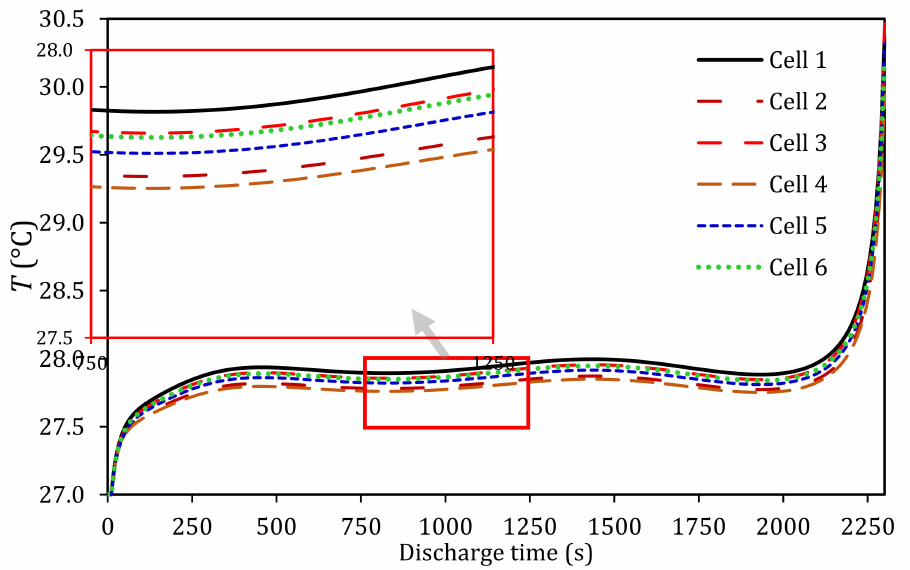
Figure 11. LIB cells temperature characteristic at a 3C discharge rate with 3M Novec